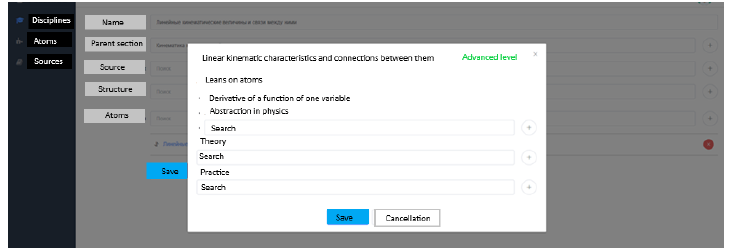
Fig. 3. The example of the links between the